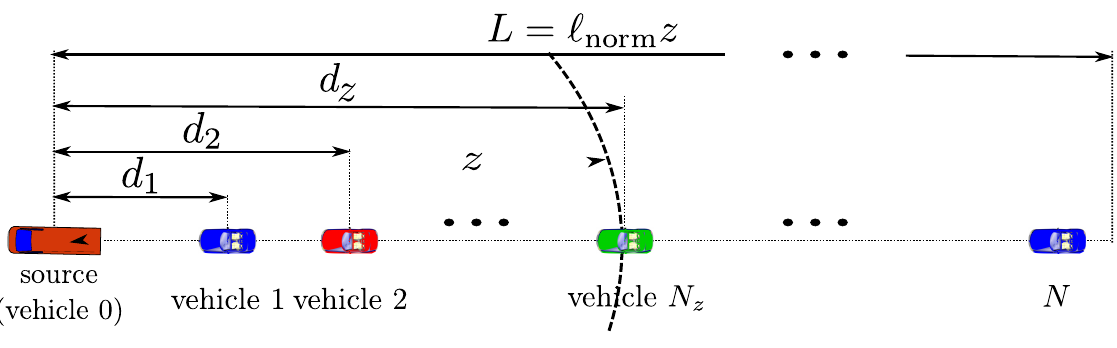
Figure 2. A typical linear network topology of a vehicular ad hoc network